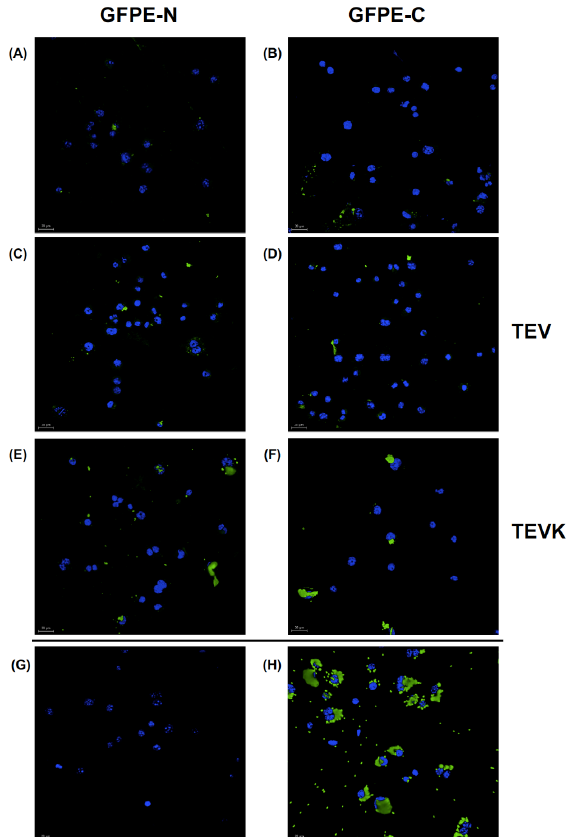
Figure 8. Phagocytosis of antigens coupled to VLPs by murine macrophages. Confocal microscopy of cells incubated with ( A ) GFPE-N or ( B ) GFPE-C alone, ( C ) GFPE-N or ( D ) GFPE-C mixed with TEV VLPs, ( E ) GFPE-N or ( F ) GFPE-C mixed with TEVK VLPs. ( G ) Untreated cells and ( H ) Cells incubated with latex beads coupled to FITC as positive control. Nuclei stained with DAPI. Scale bar: 20 m.